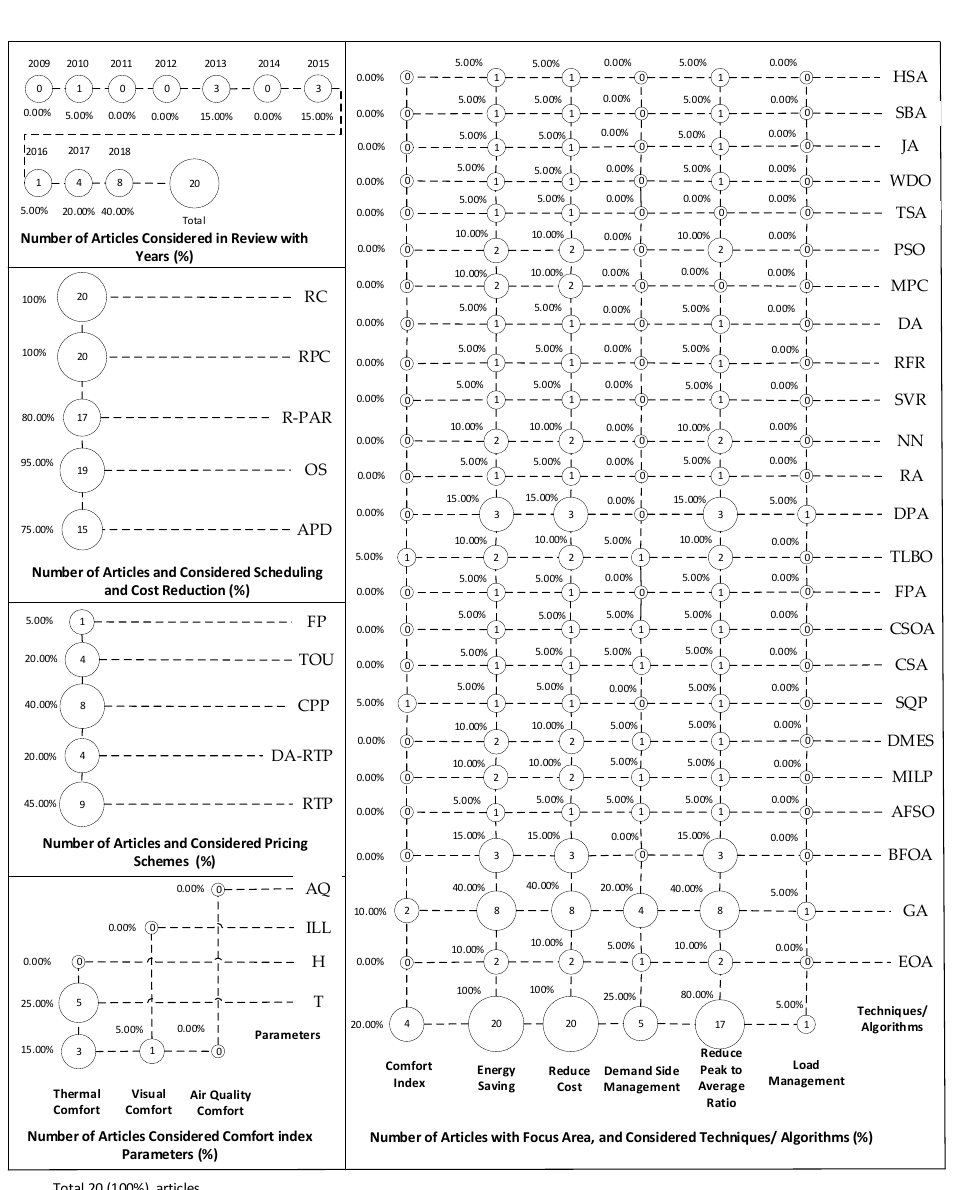
Fuselli et al. in [71] have used neural network-based action-dependent heuristic dynamic programming (ADHDP) for the energy scheduling in residential buildings using historical data. They have used particle swarm optimization (PSO) for the pre-training and enhancement of the optimization in the proposed algorithm. A model predictive methodology for HVAC load management considers the inside temperature for the calculation of the cost of electricity [72]. The method provides energy efficient control to the customers for energy management as per their requirement and preferences of inside temperature, using the temperature set-point assignment (TSA) algorithm. They have used